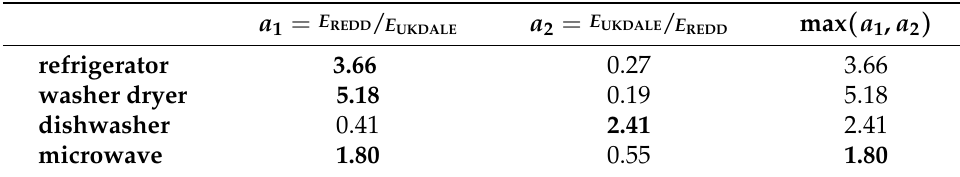
Table 5. Comparison between energies of individual consumption signals.